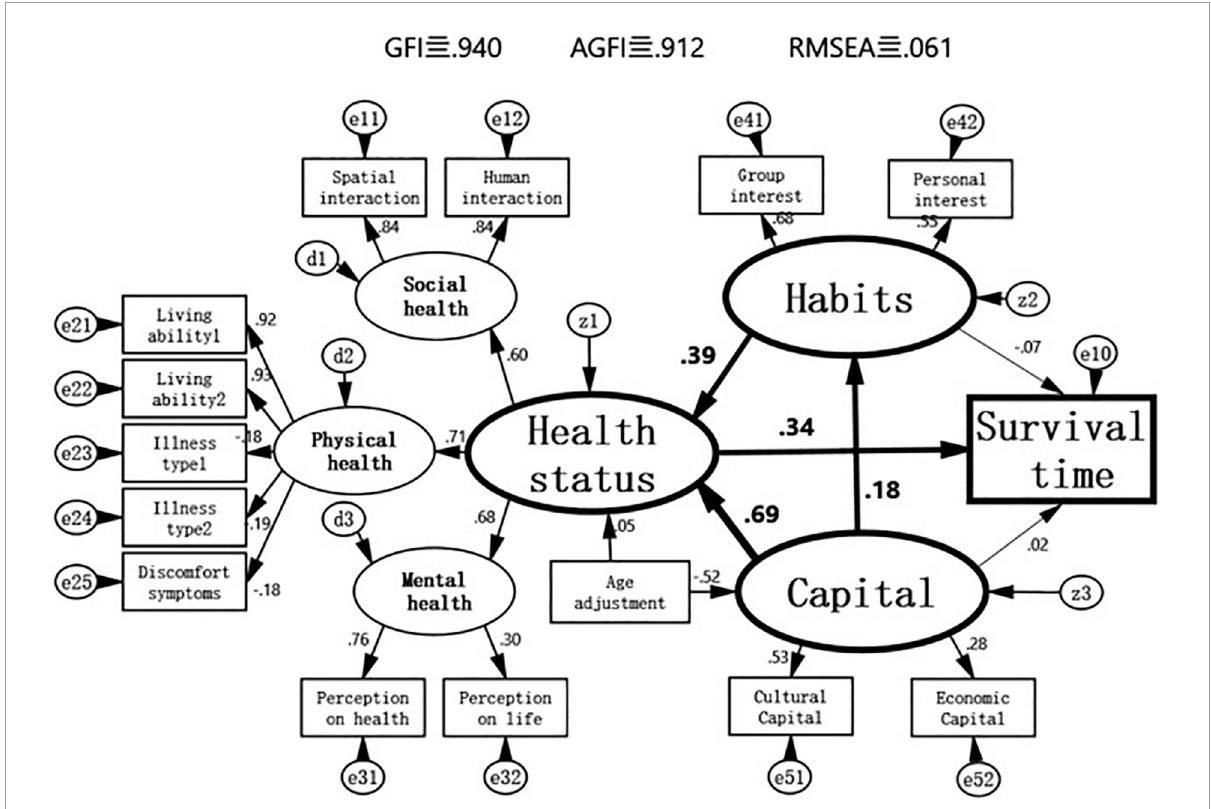
FIGURE5 Structural equation model of capital, habitus and health of the elderly in Shenyang City,